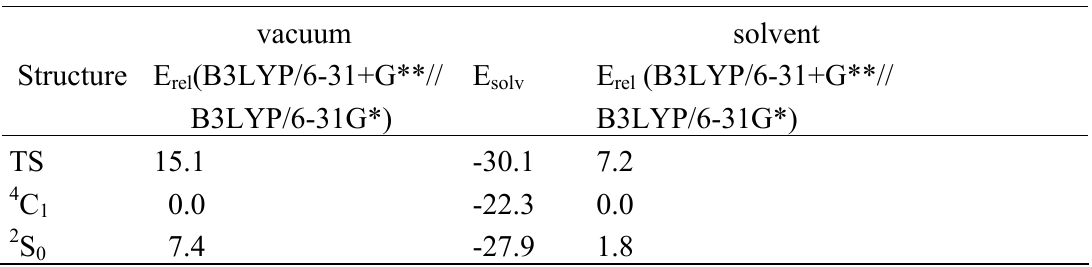
Table 8 . Vacuum and solvent properties of IdoA not include zero-point